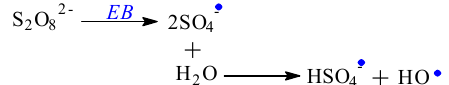
Figure 5. Possible mechanism for obtaining radicals by irradiation from initiator, potassium persulfate.